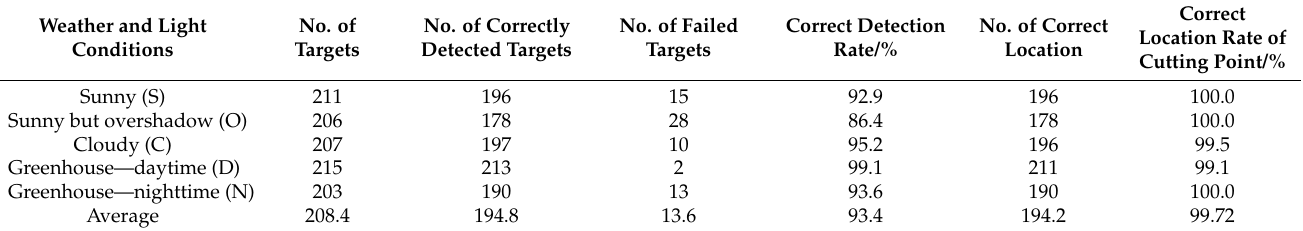
Table 2. Results of cutting experiments.